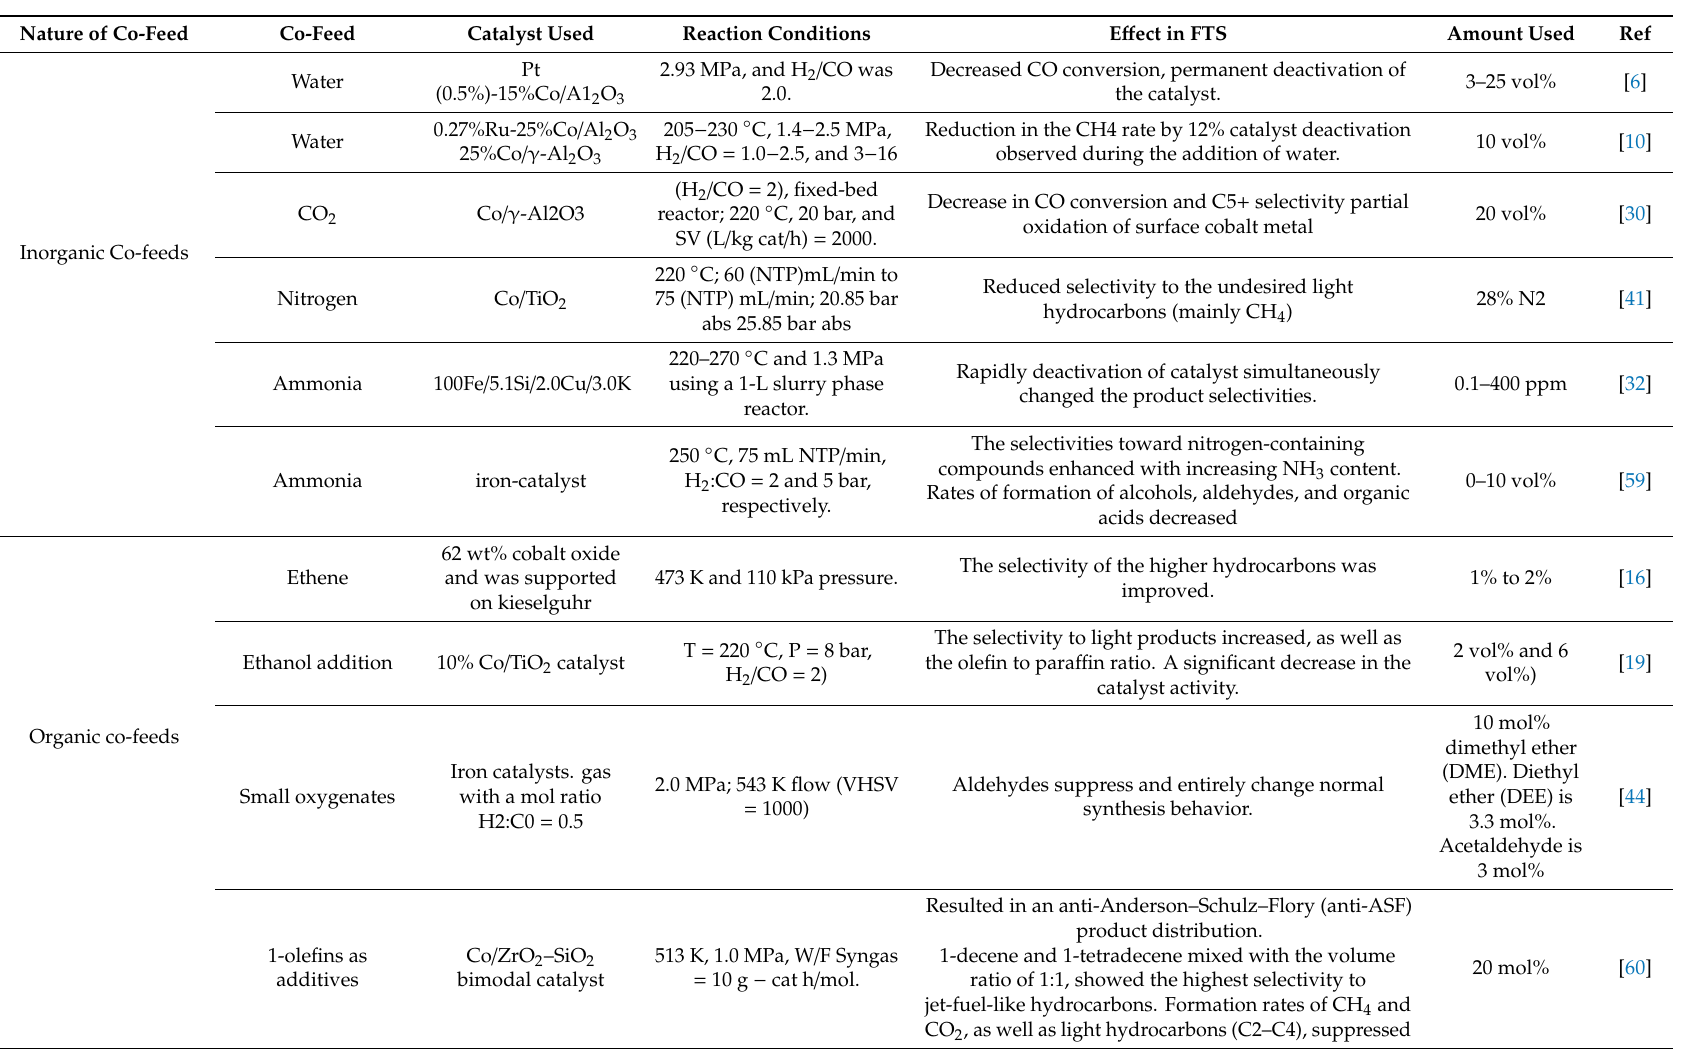
Table 1. Summary of some e ff ects of the co-feeds used in Fischer–Tropsch synthesis (FTS). The Co-feeds are grouped as organic or